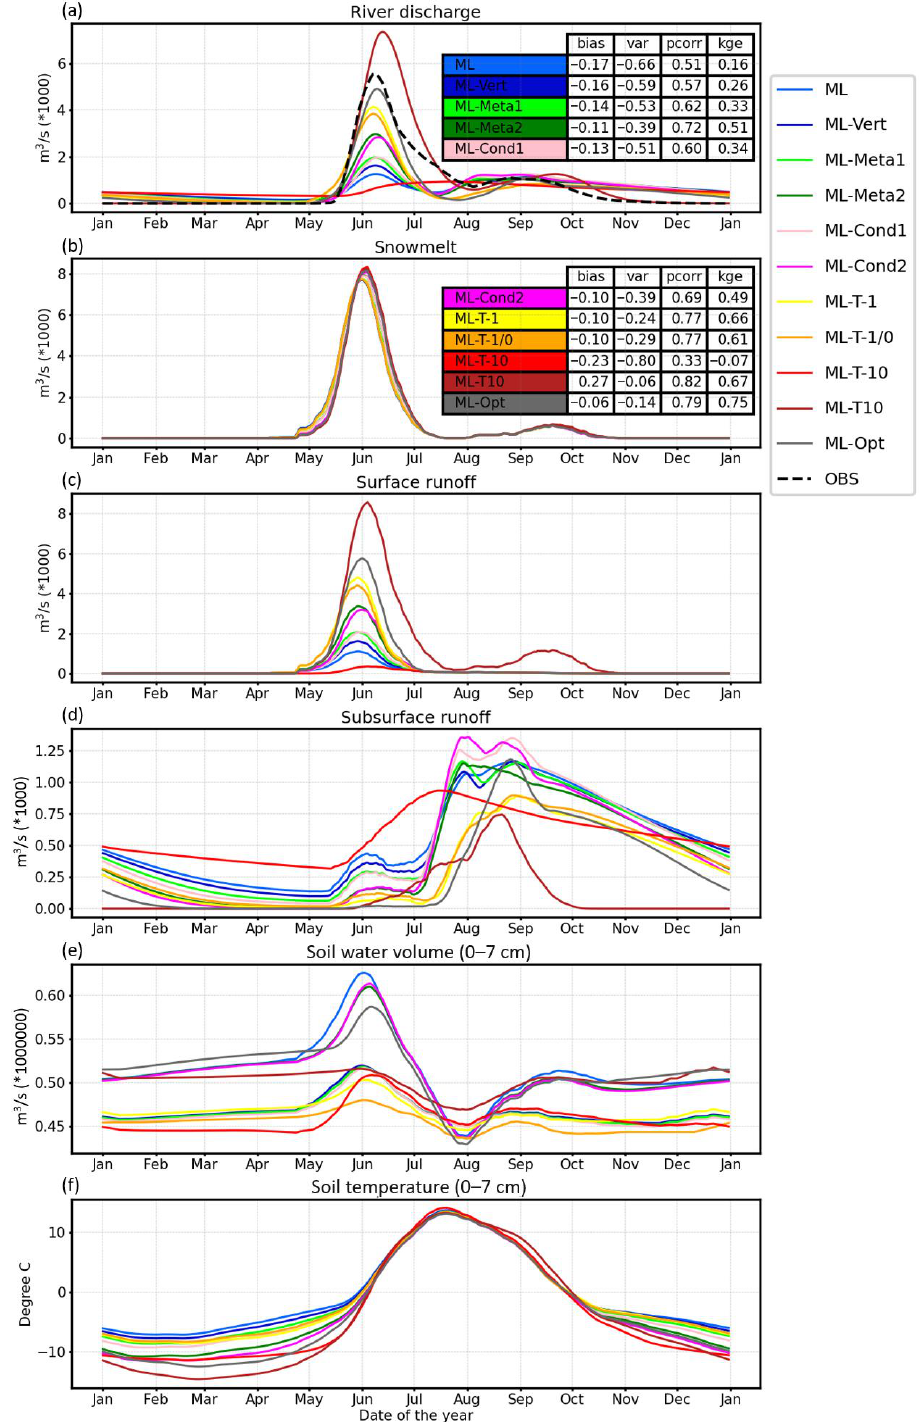
Figure 5. Daily climatological mean time series of ( a ) river discharge, ( b ) snowmelt, ( c ) surface runoff, ( d ) subsurface runoff, ( e ) water content and ( f ) temperature in the top 7 cm of the soil from ML, ML-Vert, ML-Meta1, ML-Meta2, ML-Cond1, ML-Cond2, ML-T-1, ML-T-1/0, ML-T-10, ML-T10 and ML-Opt experiments for the Olenek river at the station of Sukhana in eastern Siberia (with area of 127,000 km 2 ). All water related variables are displayed as catchment totals in order to compare them directly to river discharge, while for soil temperature catchment averages are shown (please note the values are divided by 1000 for river discharge, snowmelt and subsurface runoff and by 1,000,000 for soil water volume). The kge and its bias , var and pcorr component scores are provided in an inset table for river